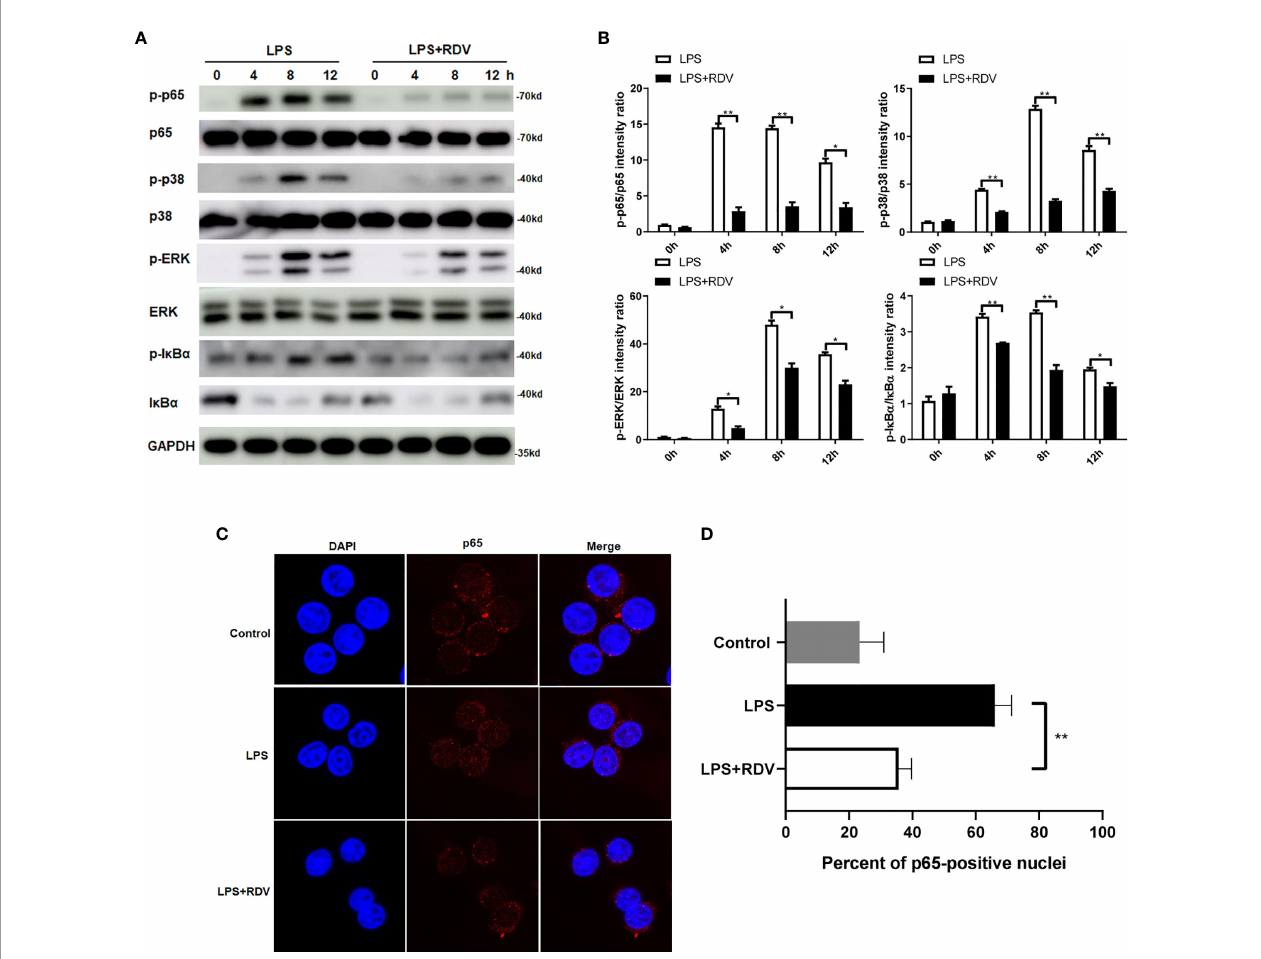
FIGURE 2 | RDV suppresses the activation of NF- k B and MAPK signaling pathway. (A) Western blot analysis of p-p65, p65, p-p38, p38, p-ERK, ERK in mouse peritoneal macrophages under of LPS, RDV and LPS+RDV stimulation at the indicated time point. (B) Relative intensity analysis of p-p65/p65, p-p38/p38, p-ERK/ ERK, p-I k B a /I k B a . (C) Macrophages were stimulated with LPS, LPS + RDV and nuclear translocation of p65 (Red) was determined. (D) Quantitative analysis of p65- positive nuclei. Data are presented as mean values ± SD from three independent experiments. *P < 0.05**; P <